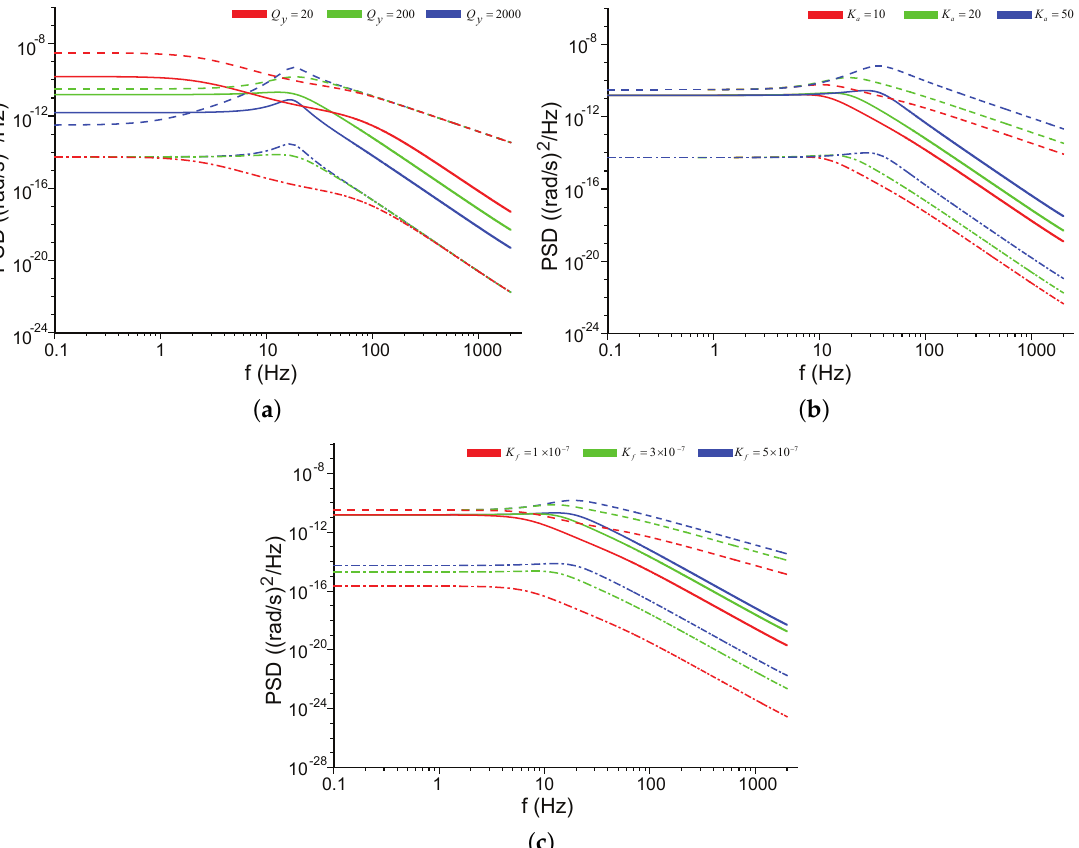
Table 2. Comparison of (cid:101) S Ω ( 0 (cid:101) S Ω N